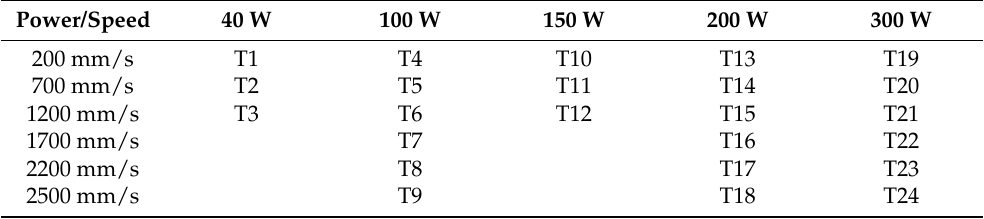
Table 1. Process